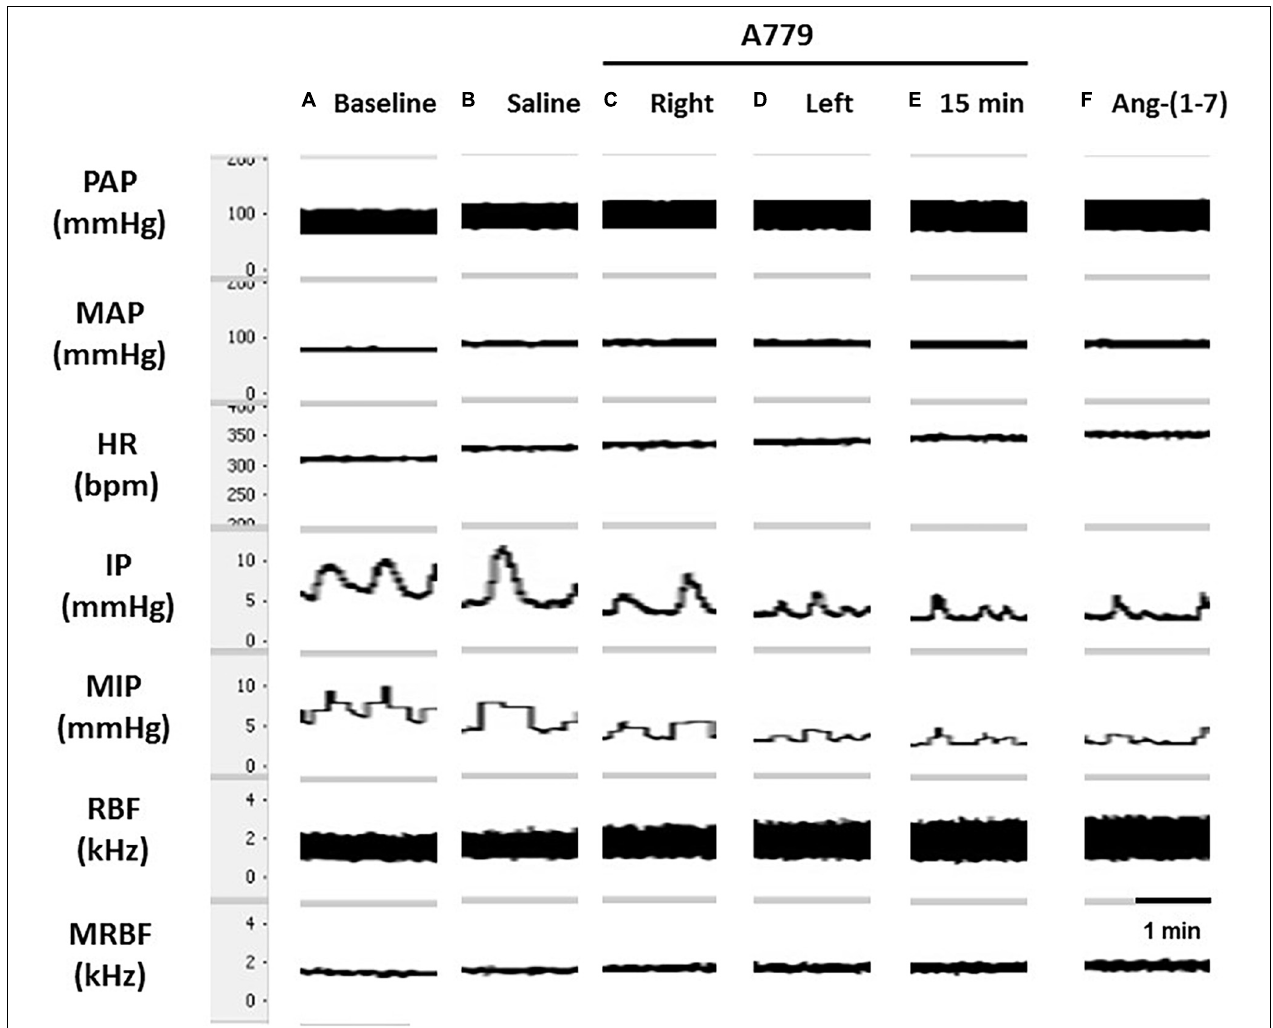
FIGURE 6 | Tracings showing (A) the baseline pulsatile arterial pressure (PAP, mmHg), mean arterial pressure (MAP, mmHg), heart rate (HR, bpm), intravesical pressure (IP, mmHg), mean intravesical pressure (MIP, mmHg), renal blood flow (RBF, kHz), and mean renal blood flow (MRBF, kHz), and the responses evoked by (B) bilateral injections of saline (vehicle, 1 µ L) or (C–E) A-779 (50 nmol/ µ L, Mas receptor antagonist, 1 µ L) into the lateral preoptic area (LPA). The effectiveness of the Mas receptor blockade was also evaluated by (F) bilateral injections of angiotensin-(1–7) [Ang(1–7)] (5 nmol/ µ L, 1 µ L) into the LPA for15 min after A-779 (50 nmol/ µ L, 1 µ